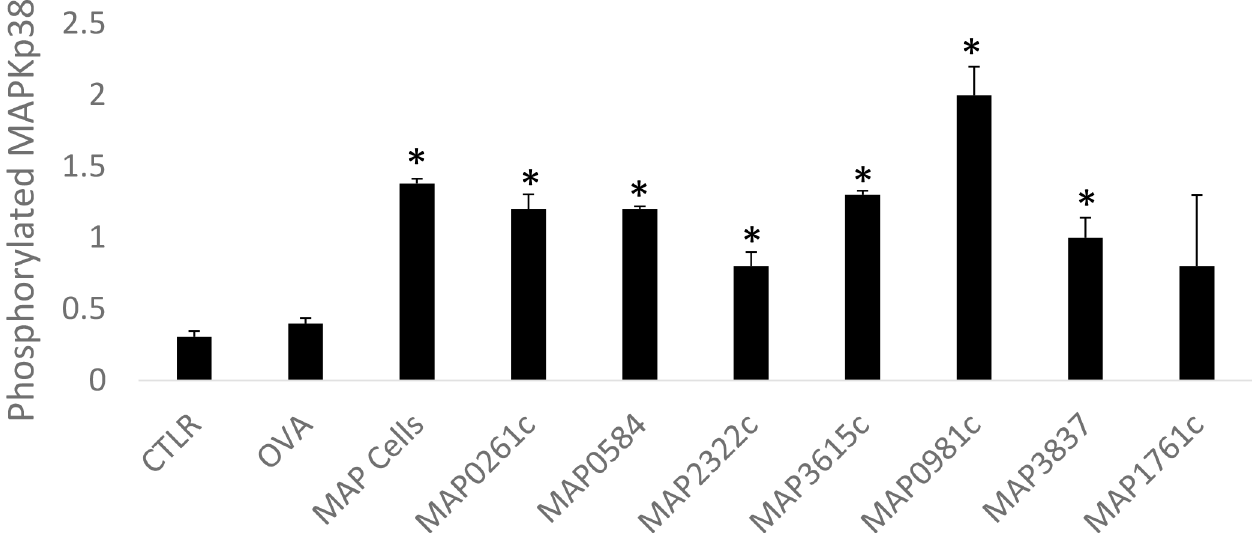
Fig 3. Phosphorylation of MAPK-p38 indicates activation of this pathway by MAP lipoproteins. Bovine macrophages exposed to M . paratuberculosis cells as well as recombinant proteins showed significant phosphorylation of MAPK-p38 compared to resting macrophages or macrophages incubated with a control peptide ovalbumin (OVA). Significantly different macrophages treated with purified proteins in comparison to macrophages alone (CTLR) are indicated with an asterisk ( * ).Error bars represent results of at least three separate